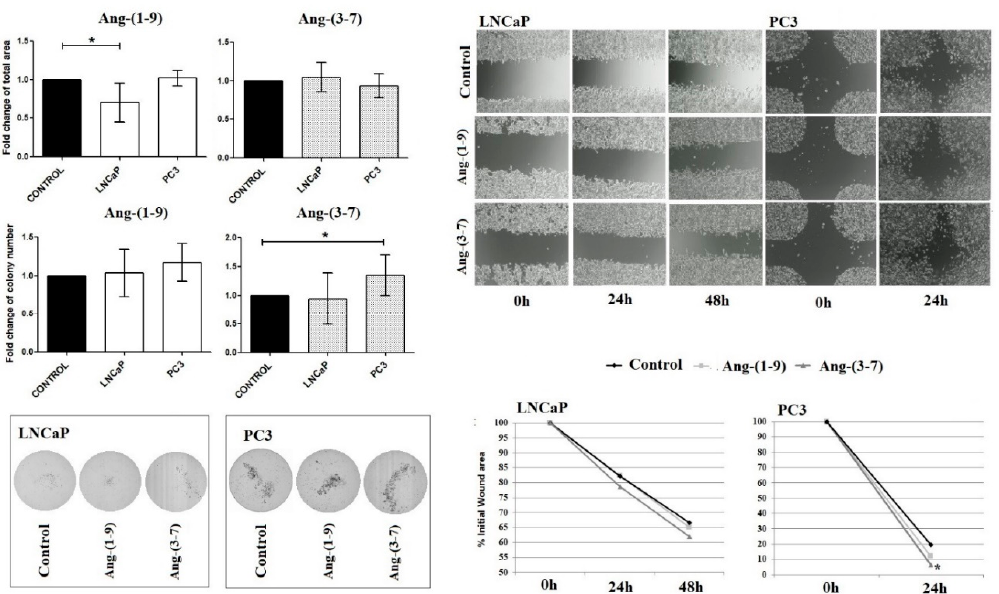
Figure 5. The Soft Agar Colony Formation Assay and Wound Healing Assay results after incubation one-way ANOVA with the post hoc Dunnett’s test: * p < 0.05). of prostate cancer cells (LNCaP, PC3) with Ang-(1-9) and Ang-(3-7) at a concentration of 1 nM (mean ± SD; one-way ANOVA with the post hoc Dunnett’s test: * p < 0.05).